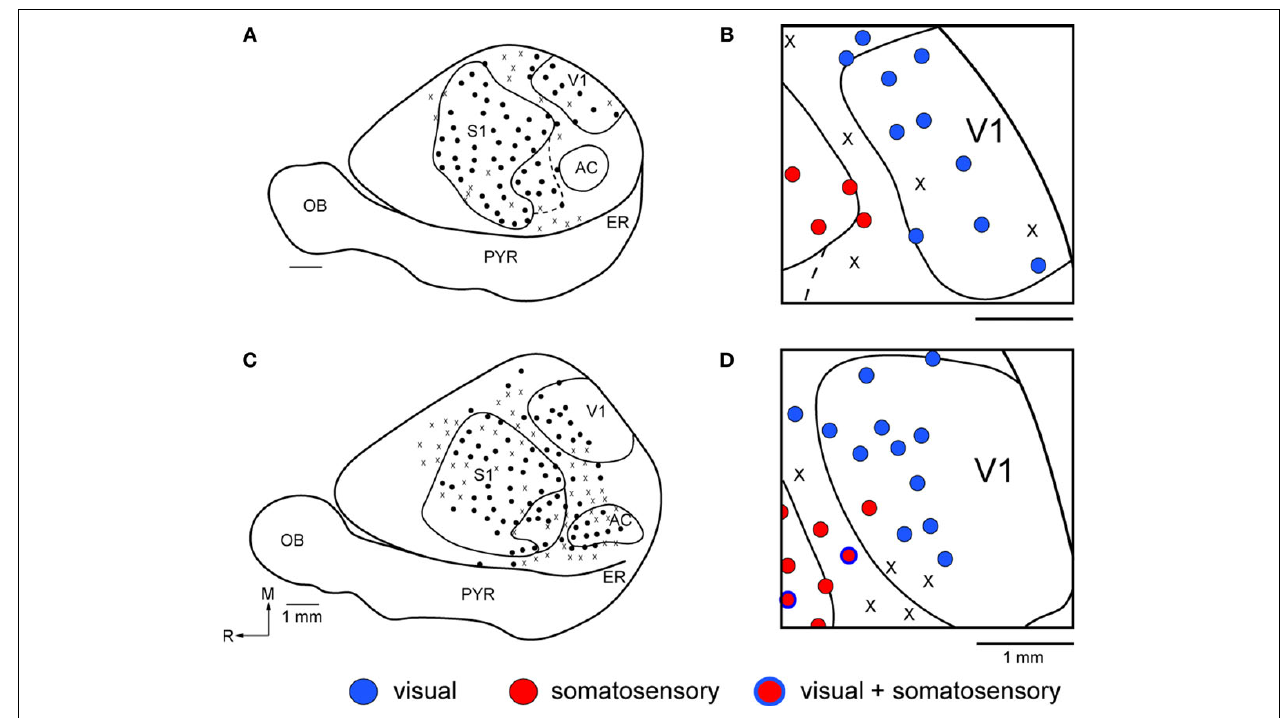
sites in visual cortex are shown in which recording sites are denoted by color coded dots indicating the sensory modality mapped to that location (B,D) . Neurons in V1 respond solely to visual stimulation, except for one site in which neurons responded to somatosensory stimulation. Medial is to the top and rostral is to the left in all images. X = No Response. Scale bars = 1